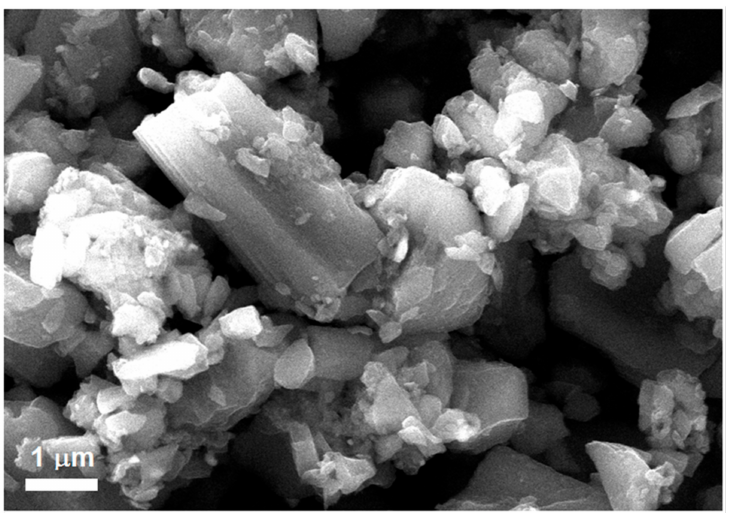
Figure 2. SEM analyses of carbon fibers after the ball milling treatment. Dimension 1 µ m, magnifica- tion 87,000 ×